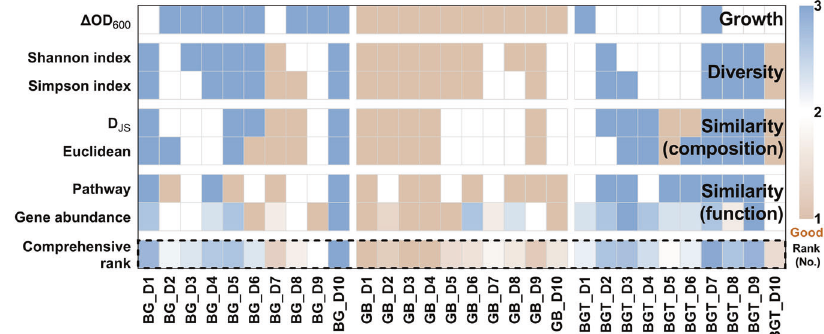
Fig. 5 Multi-dimensional evaluation of mixed media. Comprehensive rank of 30 cultures (3 media and 10 donors), which are ordered according to the D JS of composition, Euclidean, D JS of pathway level 1, variation of gene abundance from the original fecal sample (rank from 1 to 3 in ascending order), Δ OD 600 , Shannon index and Simpson index (rank from 1 to 3 in descending order), and calculated their average as comprehensive rank of each culture. The smaller rank indicates higher growth, similarity and